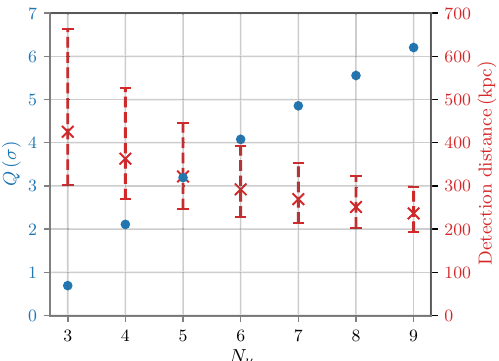
Fig. 9 Detection prospects for a CCSN whose time is known to within 1h ( m ≥ 7, (cid:5) t coin = 20ns, (cid:5) T SN = 10s). Left axis: Probability in σ that the signal is not produced by background fluctuations. Right axis: Distance at which a 27M (cid:3) progenitor mass CCSN is detected with 10% (upper boundary), 50% (middle mark) and 90% probability (lower boundary), when at least N ν detected events are required